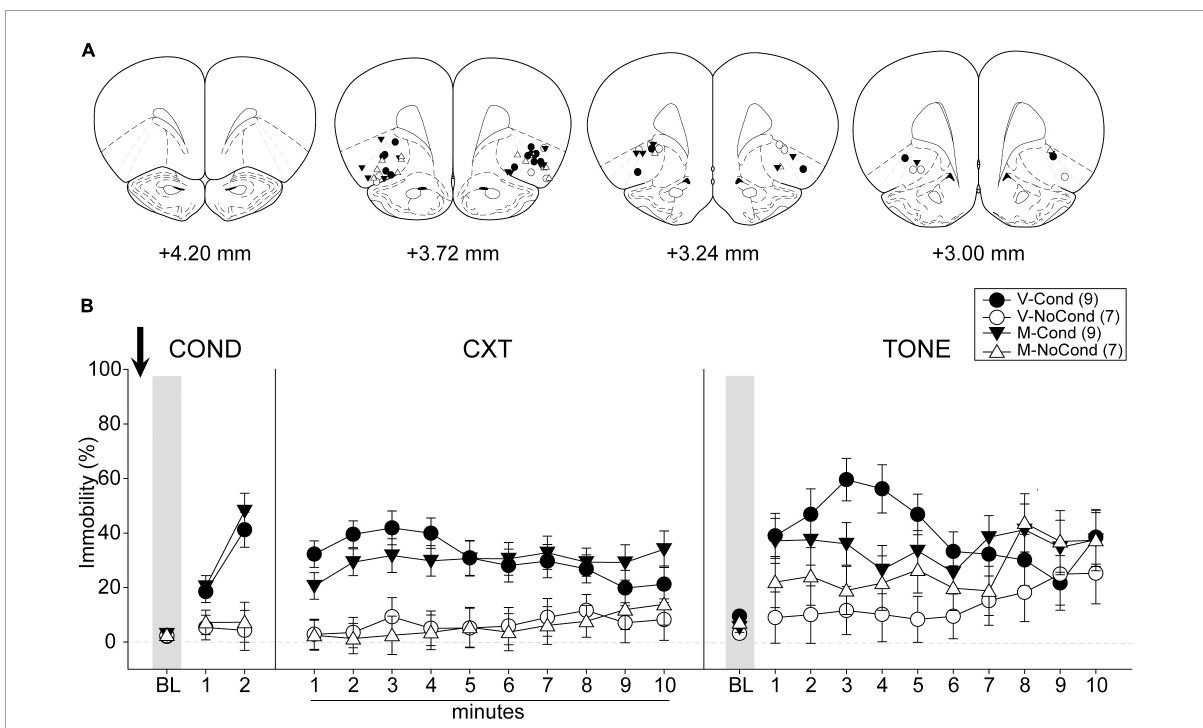
FIGURE4 Lateral OFC (lOFC) inactivation during fear conditioning left the acquisition/consolidation of fear intact. (A) Injection sites in the lOFC for all the animals included in data analyses at levels of +4.20, +3.72, +3.24, and +3.00 mm, anterior relative to bregma. (B) Percentage of immobility during the conditioning (left panel), contextual test (middle panel), and tone test (right panel). M, muscimol; V, vehicle; Cond, conditioning; NoCond, no-conditioning. All data are shown as the mean ± SEM.